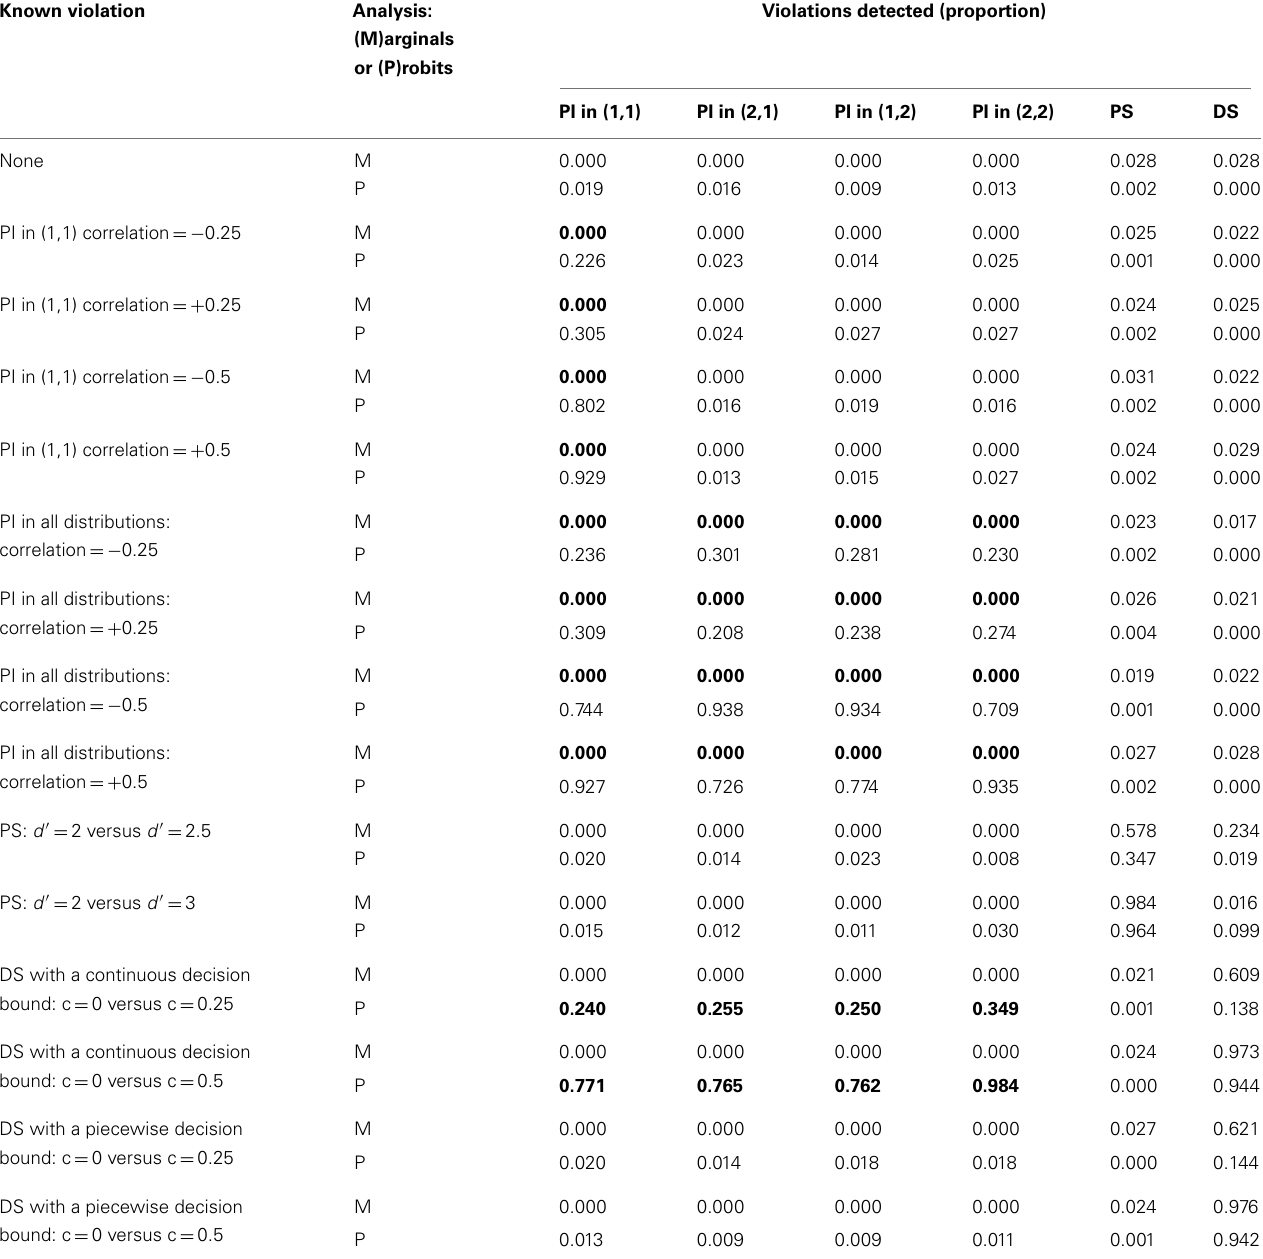
Table 1 | Proportion of 1000 confusion matrices in which violations were detected by marginal and probit analyses in simulated data with known